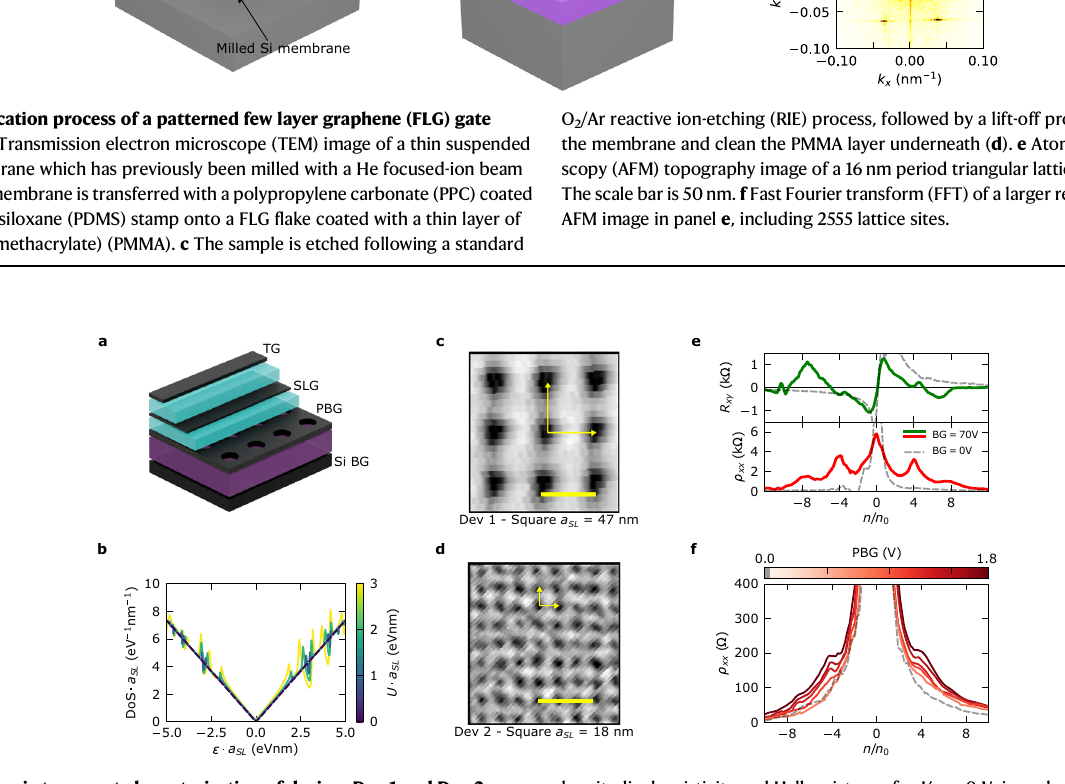
longitudinal resistivity and Hall resistance for V BG =0 V, i.e., when there is no SL modulation. In the fi rst situation, clear satellite peaks can be observed when the normalized density n = n 0 is a multiple of 4, with n 0 corresponding to the density where each SL unit cell is fi lled with one electron. This is consistent with the gra- phene´s four-fold degeneracy. f Longitudinal resistivity for Dev 2 as a function of the patterned bottom gate (PBG) applied. Satellite peaks emerge as well at nor- malized densities n = n 0 = ±4 : Gray dashed line indicates V PBG =0 V, for which no satellite peak is